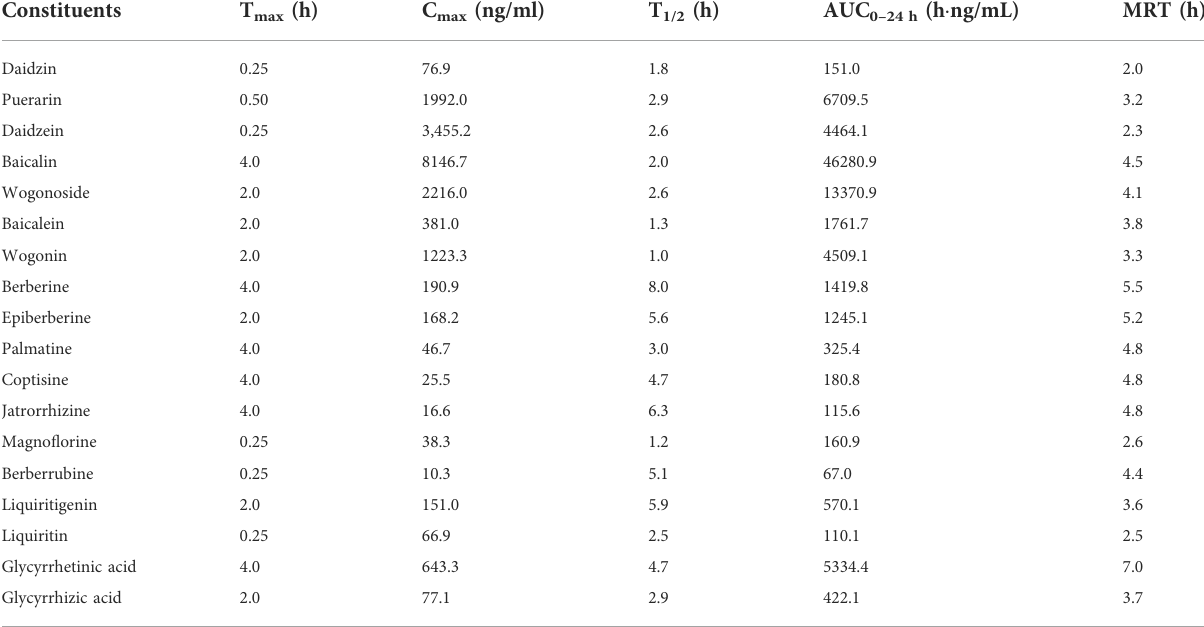
TABLE 3 Pharmacokinetic parameters of the constituents in the portal vein of the mice received oral Gegen - Qinlian decoction extract at the dosage of 6.1 g/kg (mean ± SD, n = 6).